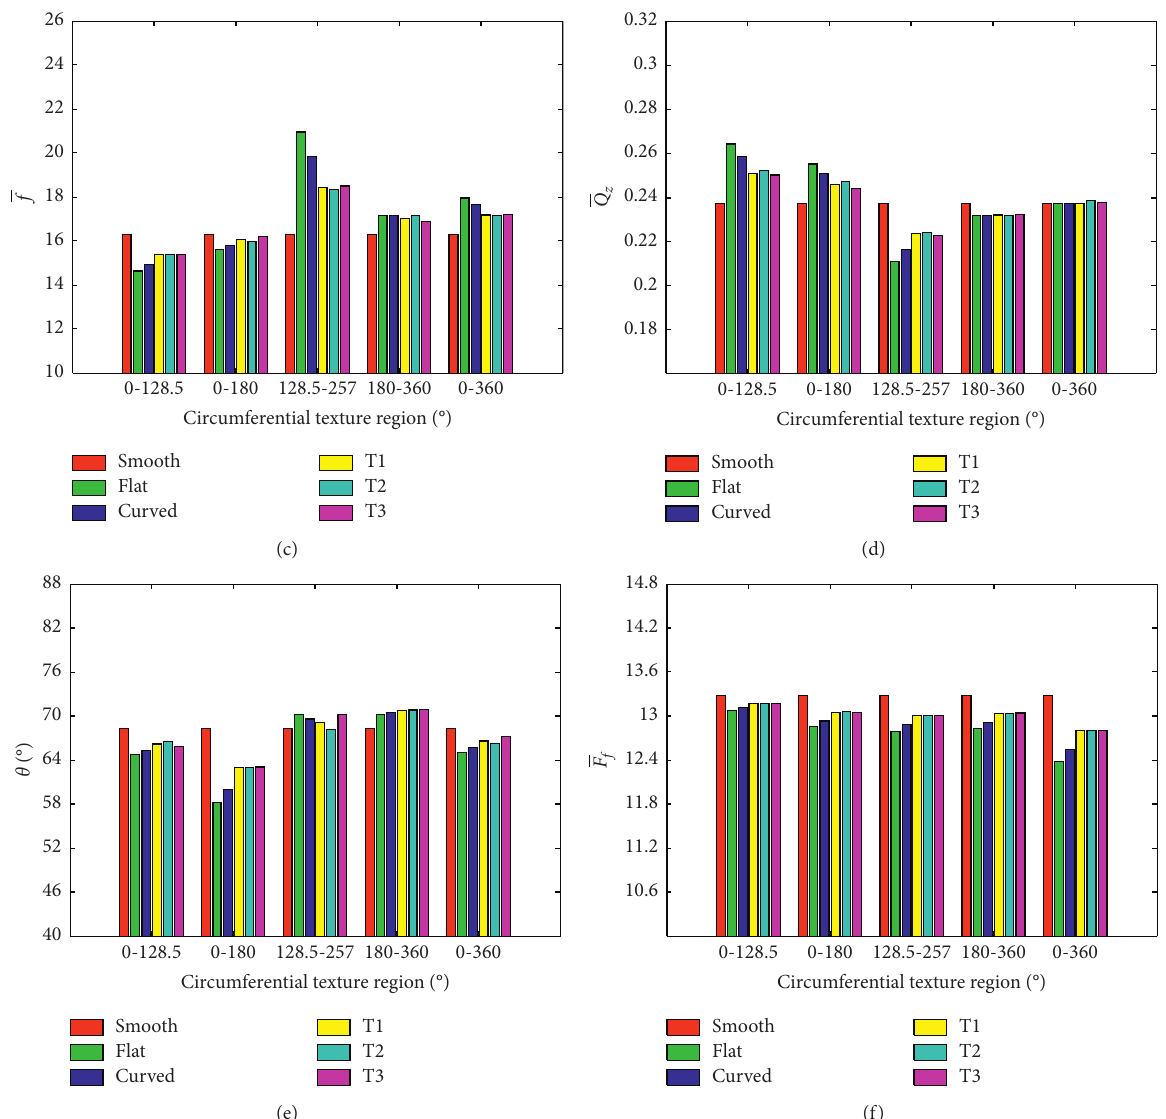
Figure 5: Effect of the circumferential texture region on static performance characteristics for smooth/textured journal bearings: (a) the load-carrying capacity ( W ); (b) the maximum fluid film pressure ( P the attitude angle ( θ ); (f) the friction force ( F f